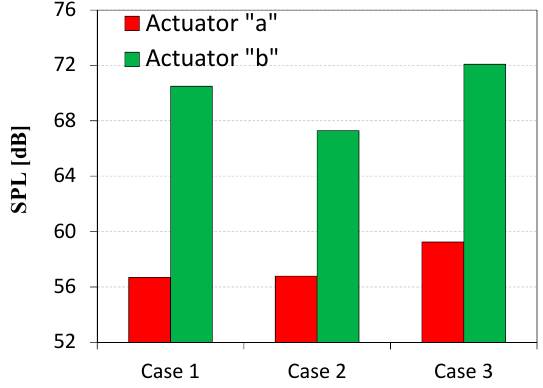
Figure 8. The SPL generated by SJAs for the characteristic frequency and P = 4 W.